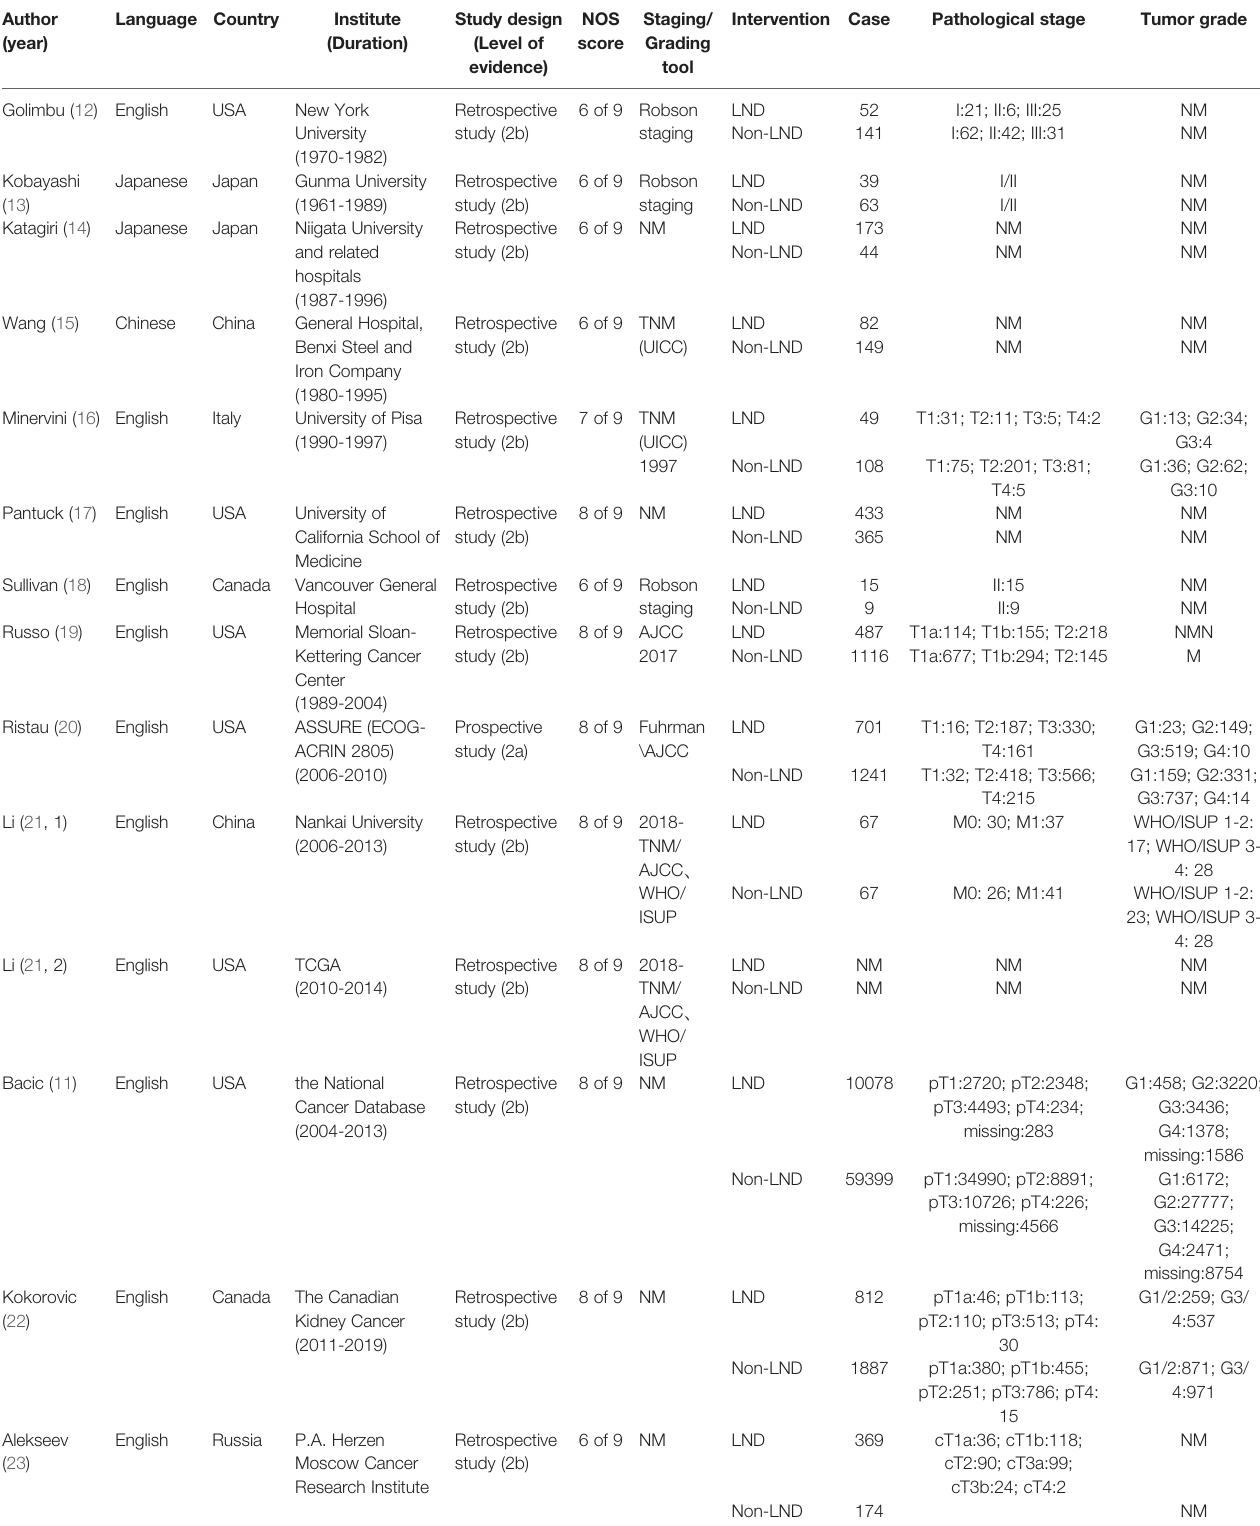
TABLE 1 | The basic characteristics of the included